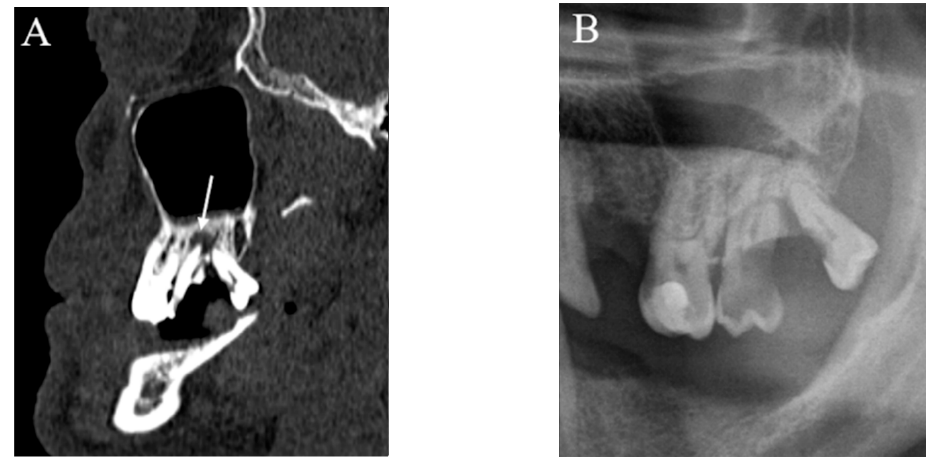
Figure 2. An example of false-positive apical periodontitis (AP). ( A ) Upper jaw MSCT imaging. No periapical bone lesion was detected (arrow). ( B ) In PAN, at the level of the periapex of the root of the left first premolar, the observers noted a radiolucent periapical image (arrow) characterised by supposed changes in bone structure that simulated AP.